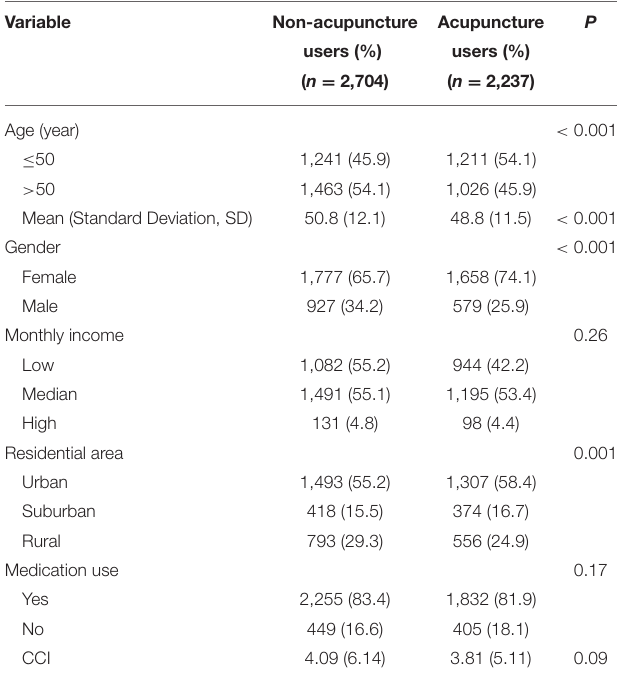
TABLE 1 | Demographic variables and comorbidities of RA subjects who received and did not receive acupuncture use.